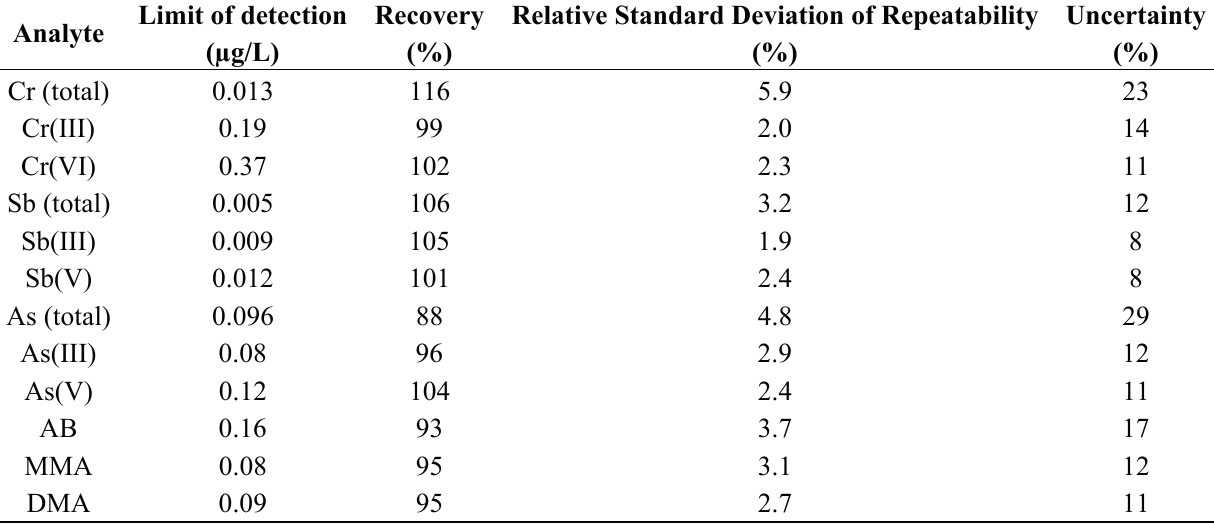
Table 4. Validation